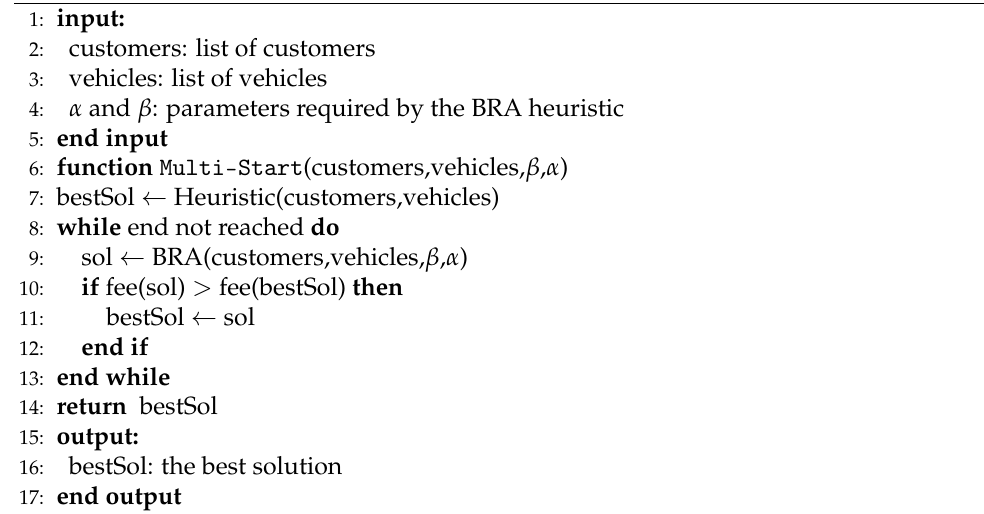
Algorithm 2 Multi-Start Approach for solving